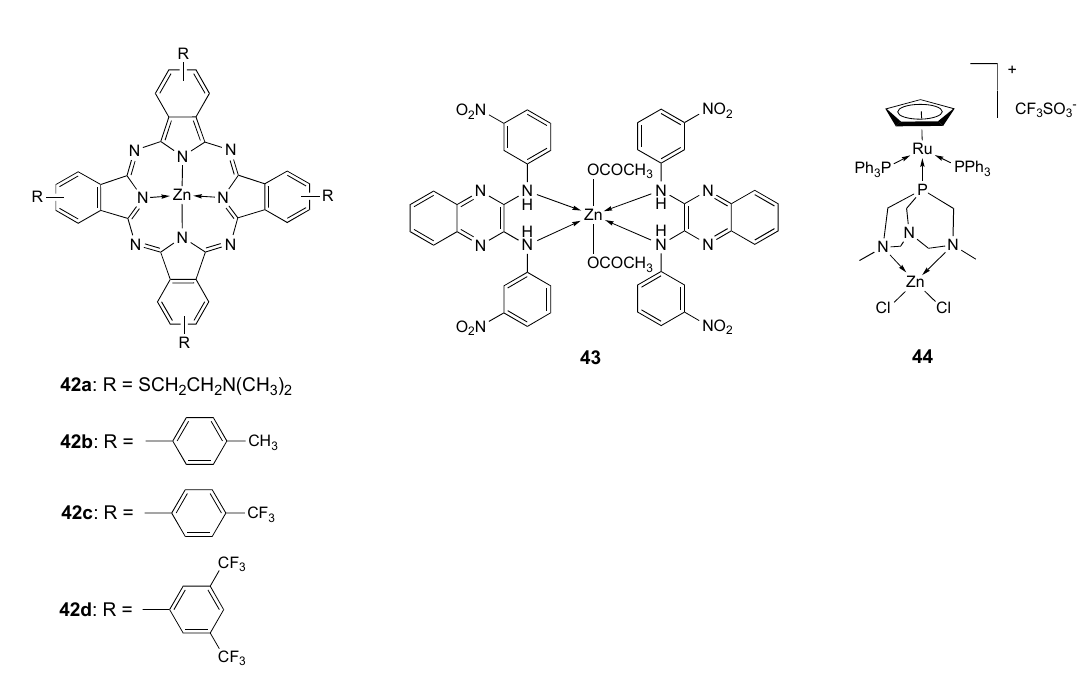
Figure 23. Structure of the zinc complexes 42 – 44 .